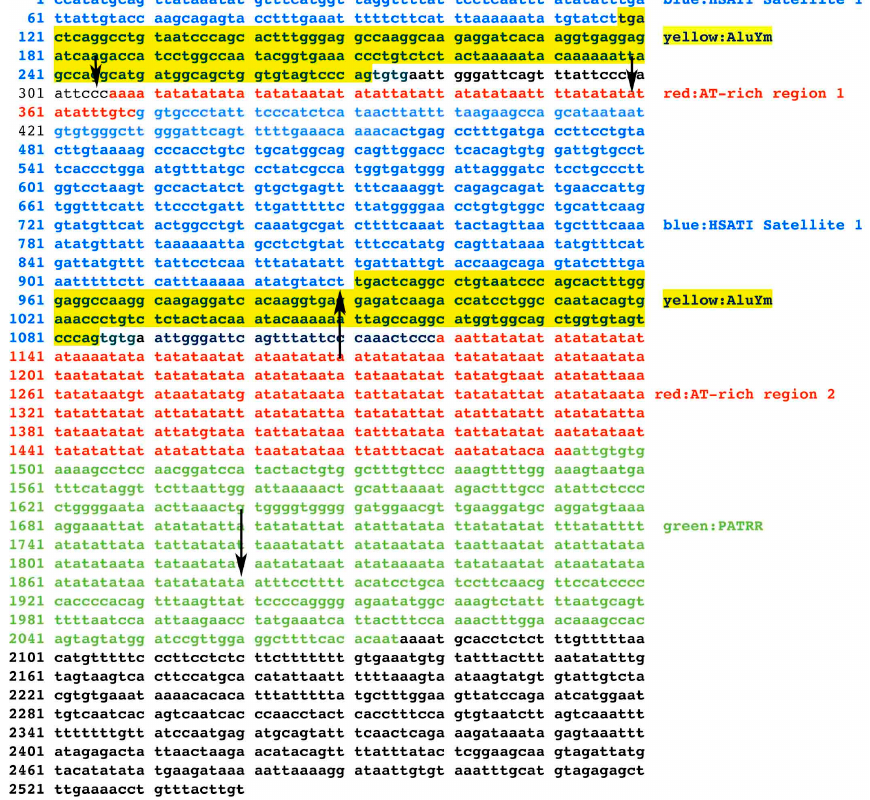
Figure 4. The TBTA sequence, highlighting the various elements it harbors, including the PATRR and AT-rich region #2 and AT-rich region #1. The sequence is from National Center of Biotechnology information (NCBI) GenBank: AB261997.1. The figure is modified from reference [13]. Two arrows (bottom) delineate the regions deleted in the RNA gene LINC01658 sequence that is equivalent to TBTA positions 930–1880, and encompasses the AluYm transposable element (in yellow), the entire AT-rich region #2 (in red), the 5’ side of the PATRR and includes all of the PATRR-associated AT-rich sequences up to position 1880 (in green). The AT-rich region #1 is also deleted (delineated by arrows at positions 305 and 359) with the exception of the very small AT sequence, positions 360–366. These deletions essentially result in RNA gene LINC01658 having no AT-rich sequences.